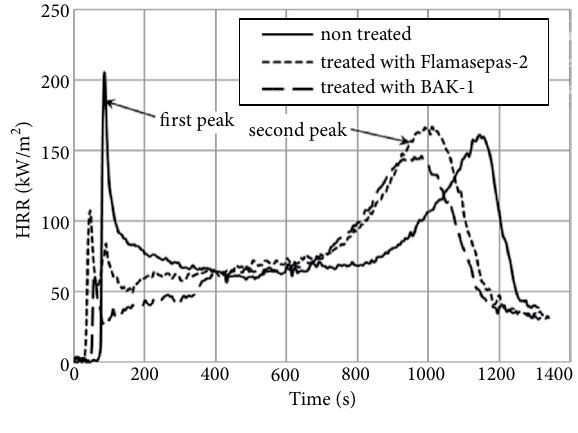
Fig. 4. Heat release rate (HRR) obtained during the combustion of non-treated and treated specimens